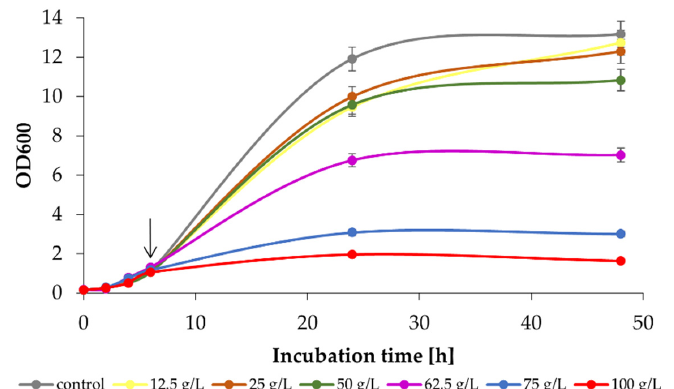
Figure 4. Effect of the presence of exogenous ethanol on the growth of K. marxianus WUT240 in comparison with a control culture without ethanol addition. Cells were grown in a SAB medium with an initial OD600 = 0.15. Ethanol at different final concentrations (12.5, 25, 50, 62.5, 75, and 100 g/L) was added when cultures reached OD600 of approx. 0.8–1.0 (indicated by an arrow). Simultaneously, the effect of lactose on yeast growth was also evaluated. For this purpose, 10-fold dilutions (up to 10 − 7 ) of overnight K. marxianus WUT240 cultures in SAB were dotted in four repetitions on plates containing rising lactose concentrations (up to 400 g/L). After 48 h incubation at 30 ◦ C, yeast growth was monitored and described as log